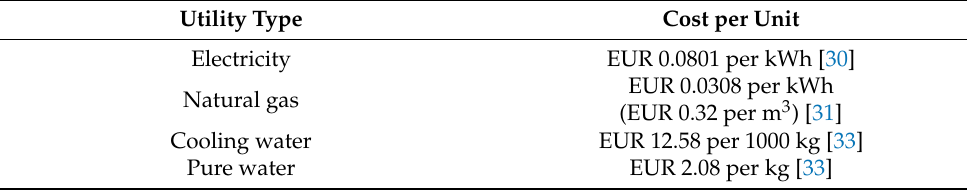
Table 4. Utility